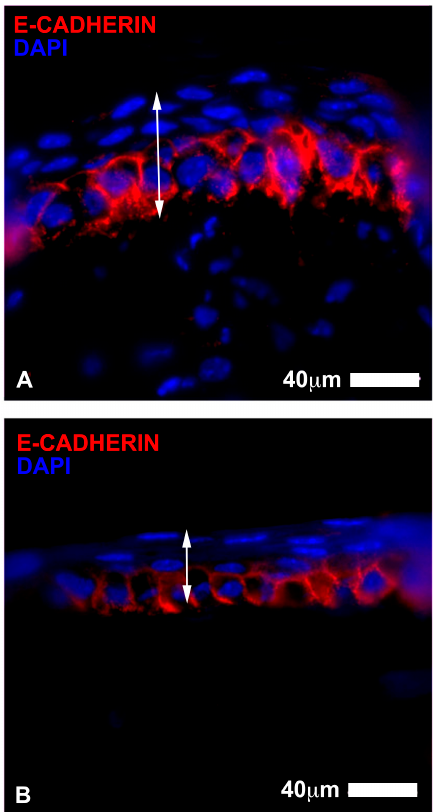
Figure 5. Corneal epithelium wound healing after three days assessed with E-Cadherin immunostaining. ( A ) represents an eye treated with ADSC. E-Cadherin (marked in red) appeared to be distributed in the basal cell layer of the epithelium and accumulated in the cytoplasm. Elongated irregular processes could be seen in the stroma; some cells presented E Cadherin staining. ( B ) represents a control eye, which showed a similar pattern of distribution of E Cadherin staining in the cornea. Nuclei are counterstained with DAPI (in blue). Note the difference in the number of layers between stem cell treated group and untreated corneas (Scale bar 40 µm).